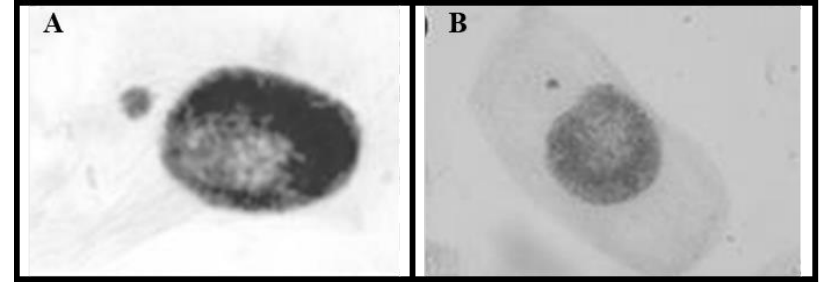
Table 7. Results of micronuclei found in analyses